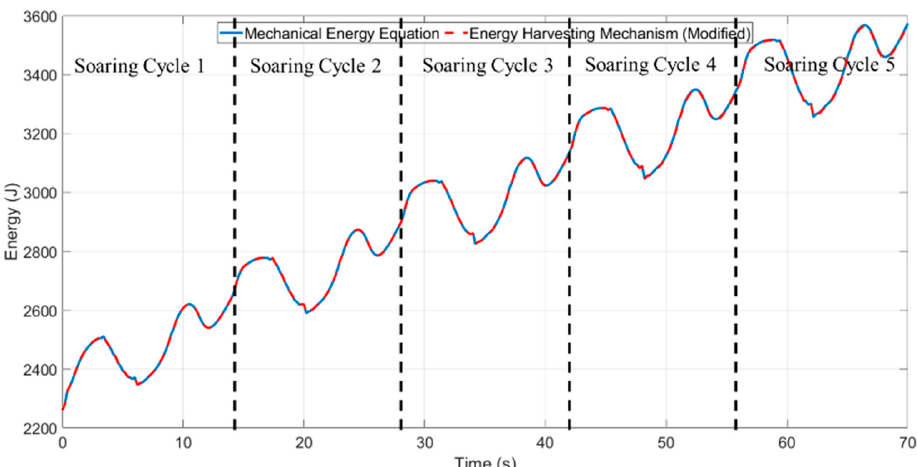
Figure 21. The energy variation curves calculate by the two methods (modified).